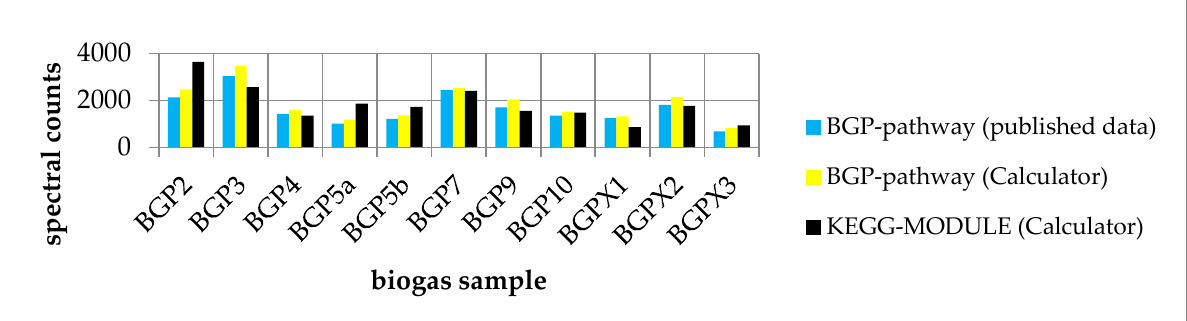
Figure 3. Comparison of experimental data mapped on each pathway (Wood–Ljungdahl pathway, acetoclastic methanogen- esis, and hydrogenotrophic methanogenesis) with published data [8]. Summed spectral counts plotted against all biogas samples are blue and yellow for user-defined pathways and black for KEGG MODULEs. The results were obtained from the ‘Pathway-Calculator’ (yellow and black) and published data (blue). In particular, acetoclastic methanogenesis showed higher spectral counts in most samples, indicating the occurrence of unspecific reactions.